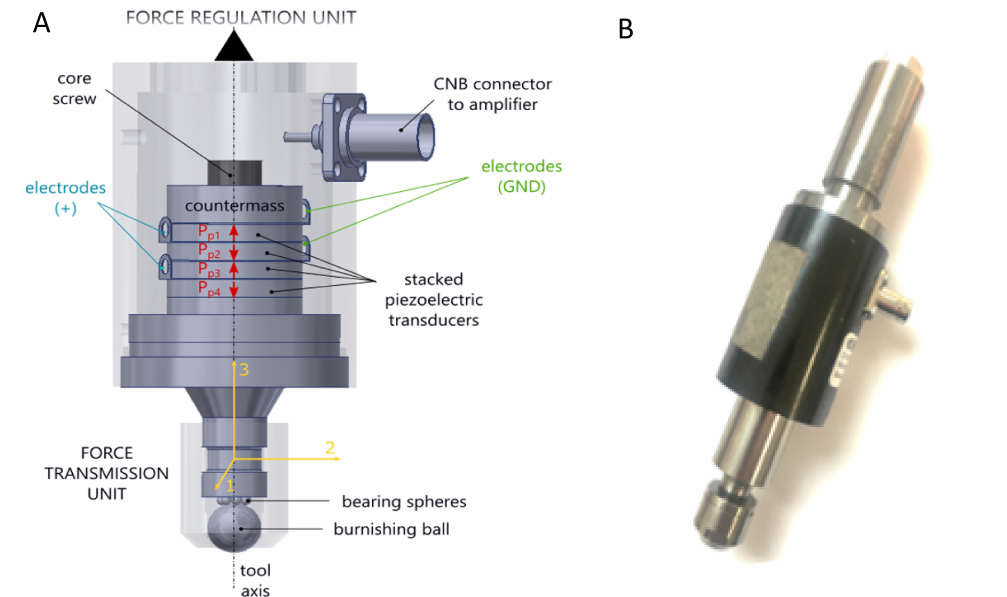
Figure 1. Ultrasonic vibration-assisted ball-burnishing (UVABB) tool equipped with a 1D linear displacement system through piezoelectric stack designed by Jerez-Mesa et al. (2018) [20]. ( A ) General scheme of the piezoelectric system; ( B ) Real image of the prototype used for vibration monitoring.